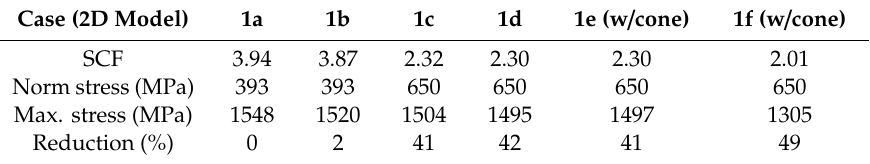
Table 10. SCF with varying parameters (straight/shank and with/without a relief cone).